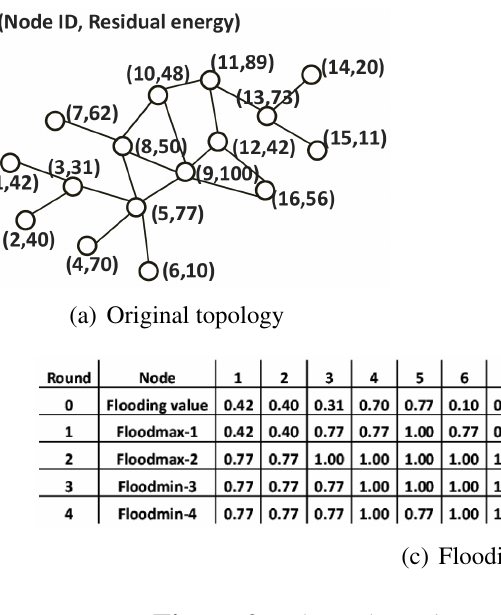
Figure 2. 2 -hop clustering - Resulting network